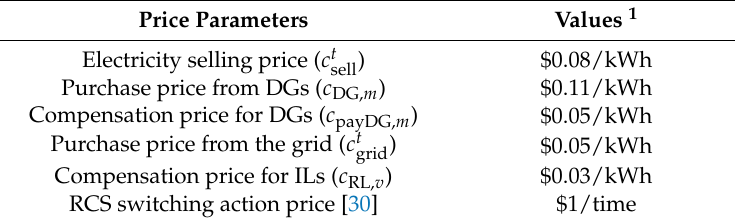
Table 1. Values of some price